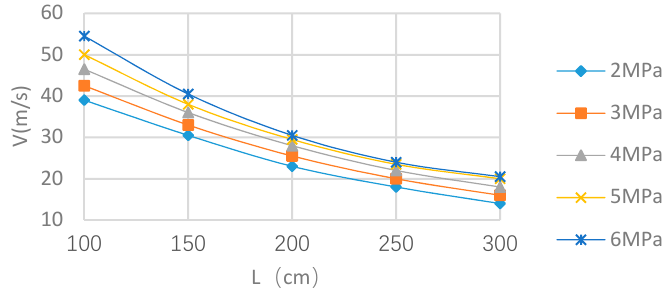
Figure 10. Droplet velocity in different spray pressures.